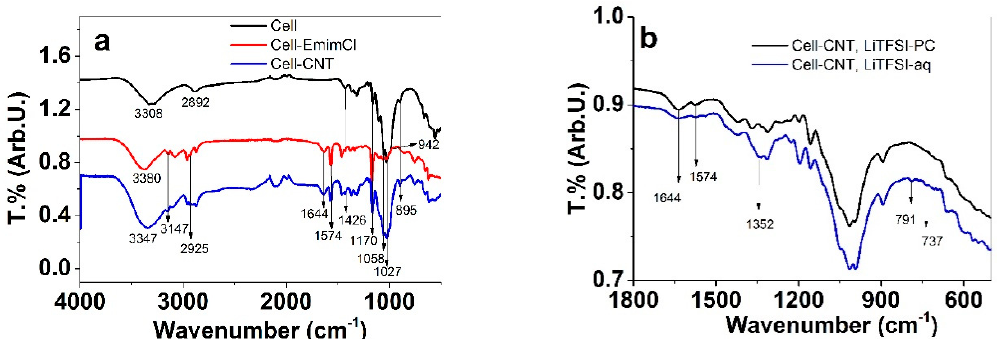
Figure 2. Fourier-transform infrared spectroscopy (FTIR) spectra: ( a ) unprocessed cellulose (black line), cellulose with 1-ethyl-3-methylimidazolium chloride (EMIM-Cl) (red line) and regenerated cellulose-MWCNT composite (blue line); ( b ) the comparison of Cell-CNT actuated in LiTFSI-PC (black line) and LiTFSI-aq (blue line).